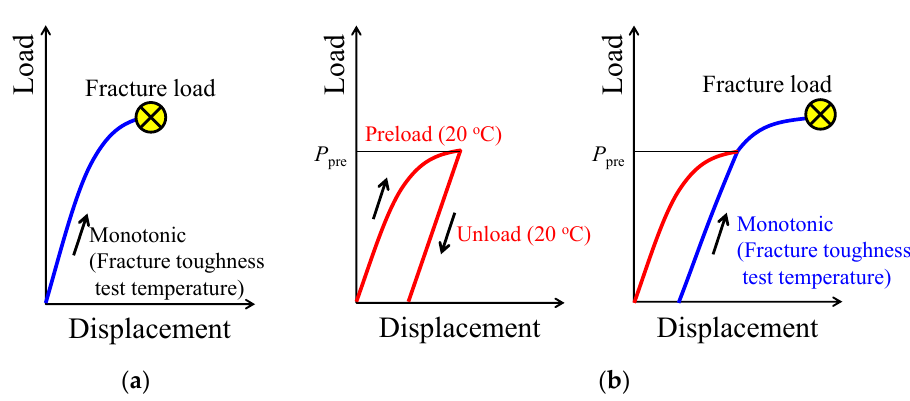
Figure 2. Loading pattern for fracture toughness tests without and with compressive residual stress (CRS): ( a ) case without CRS and ( b ) case with CRS. In case ( b ), the first figure represents the case in which CRS is applied by preloading the specimen to P pre at 20 °C, and the second figure represents the case in which the specimen is loaded to fracture at the same temperature as that in case ( a ).